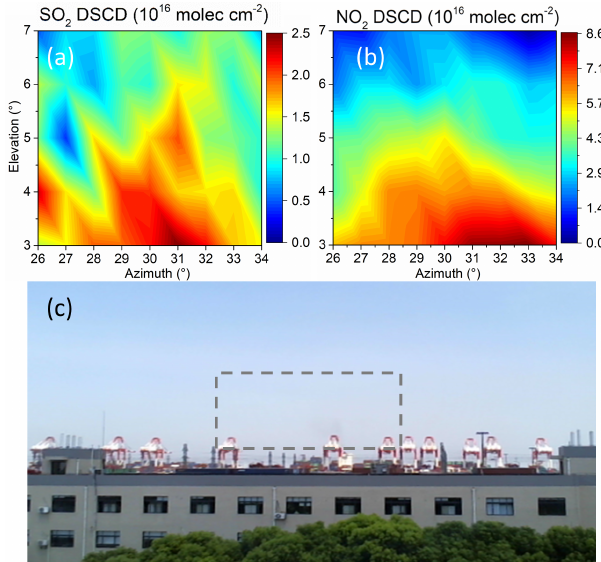
Figure 4. The observational geometry of the MAX-DOAS for iden- tifying the emissions of ships at berth in the Waigaoqiao port, Shanghai: (a) top view and (b) side view.